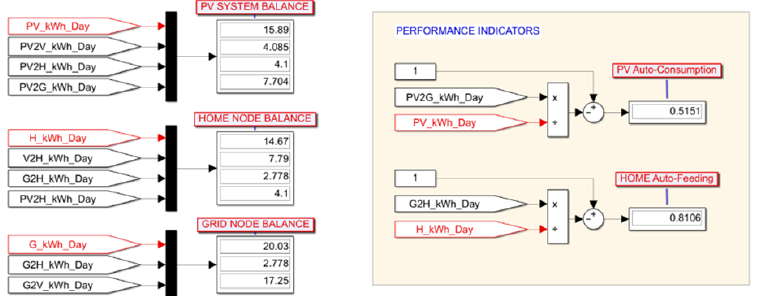
Figure 20. Energy balances at the main nodes ( left ) and performance indicators ( right ) for Case2B — SW 2D.